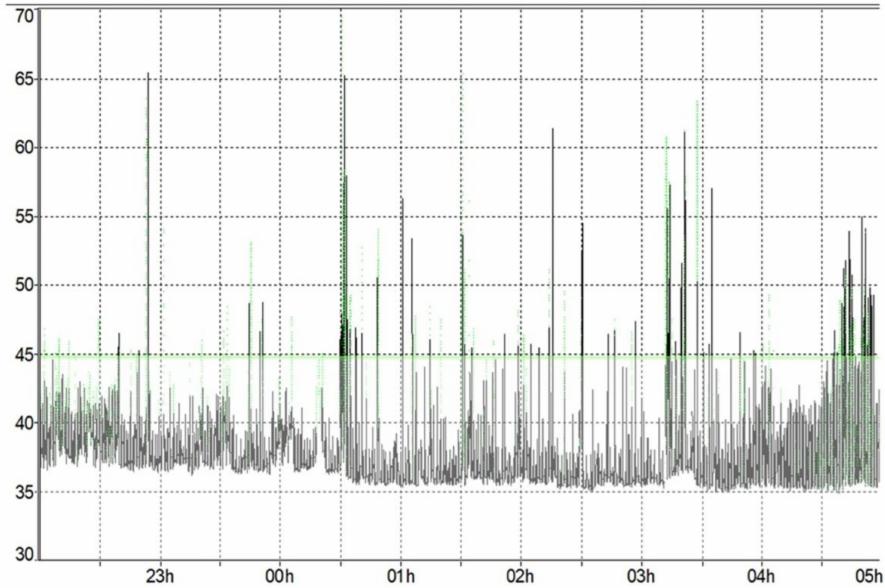
Figure 9. Time history of the second night (in green, the threshold exceedances set to L Aeq = 45 dB(A)). It is evident that during the two nights of measurement, numerous events occurred that exceeded the level set as the wake-up threshold (45 dB(A)). The number of total events with L Aeq > 45 dB(A) during the first night is 50 while the second night period is characterized by a much larger number of events, 191, quadrupling those recorded the previous night, as shown in Figure